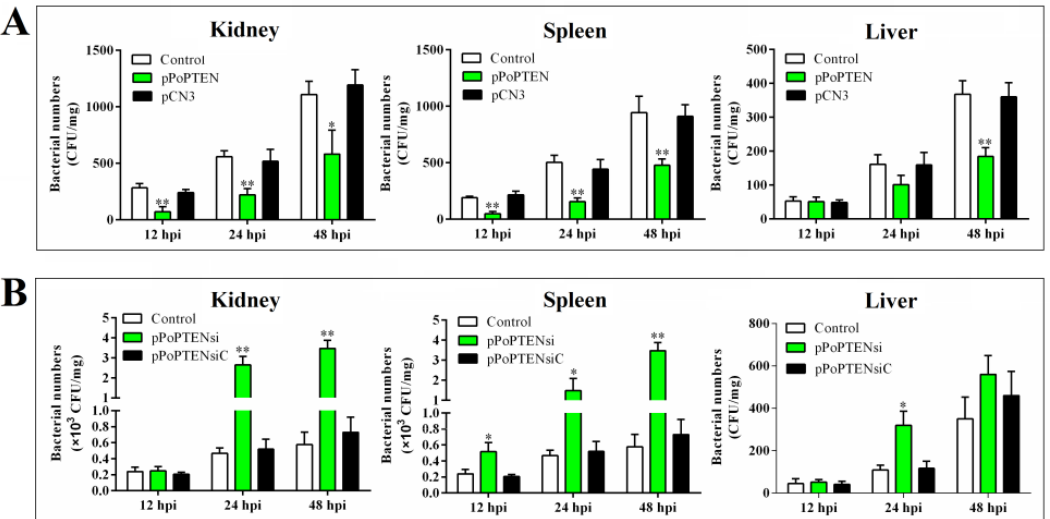
Figure 4. In vivo effects of PoPTEN on bacterial infection in flounder. For PoPTEN overexpression, flounder were treated with or without (control) pPoPTEN or the control plasmid pCN3 ( A ), for PoPTEN knockdown, flounder were treated with or without (control) pPoPTENsi or the control plasmid pPoPTENsiC ( B ). The fish were infected with Edwardsiella tarda , and bacterial numbers in kidney, spleen, and liver were determined at different times. Values are the means of triplicate experiments and shown as means ± SD. * p < 0.05; ** p < 0.01.